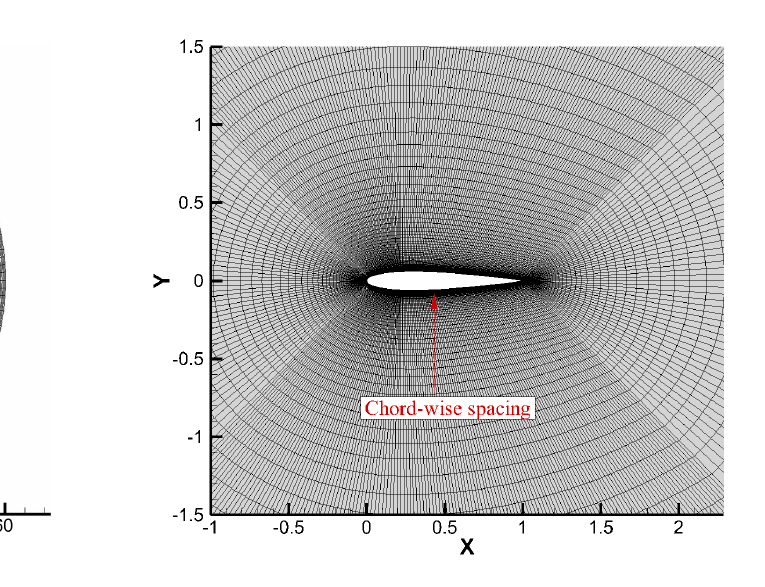
Figure 14. Node distributions for H-mesh.